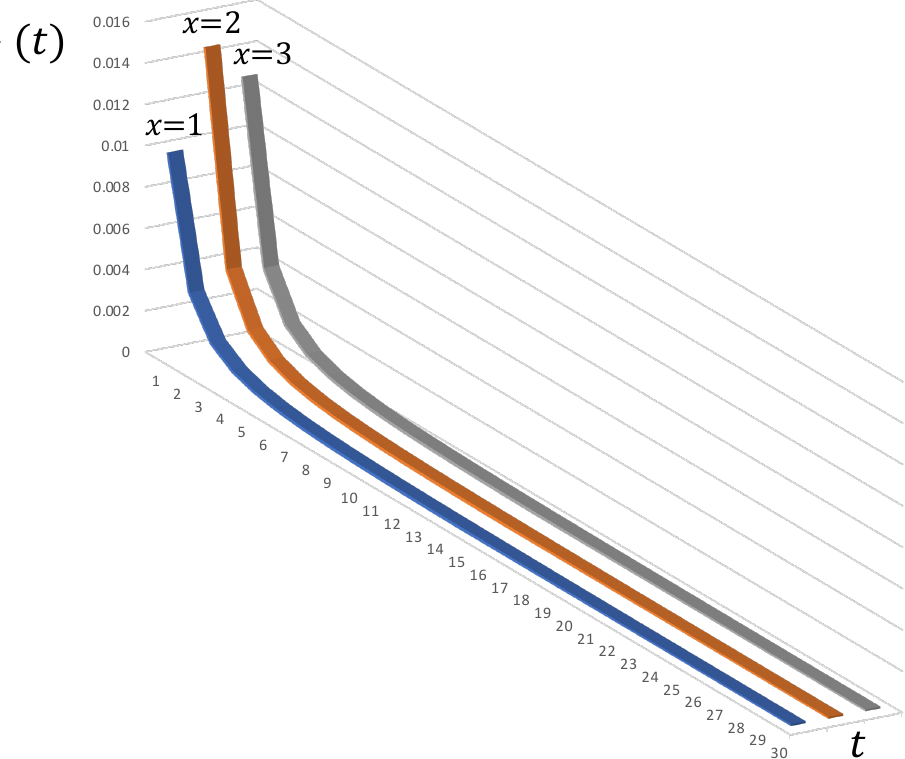
Figure 3. Probability distribution P X ( t ) for t = 30 h of operation in machine 1 for x = 1,2,3.